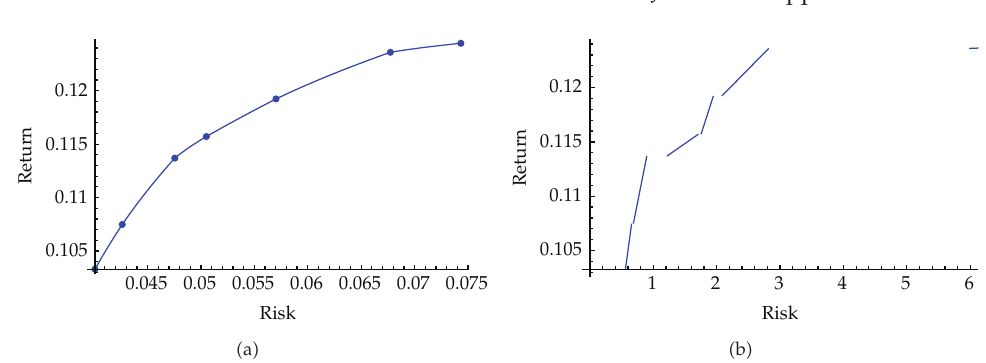
Figure 6: The exact e ffi cient frontier of a five-asset problem (cid:6) a (cid:7) and its derivative (cid:6) b (cid:7) .